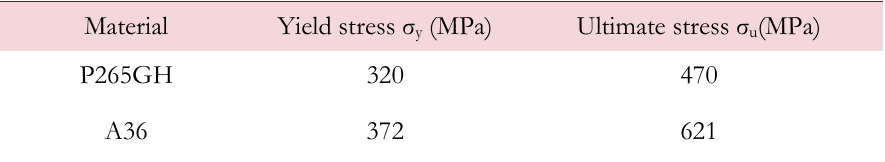
Table 3: Mechanical properties of